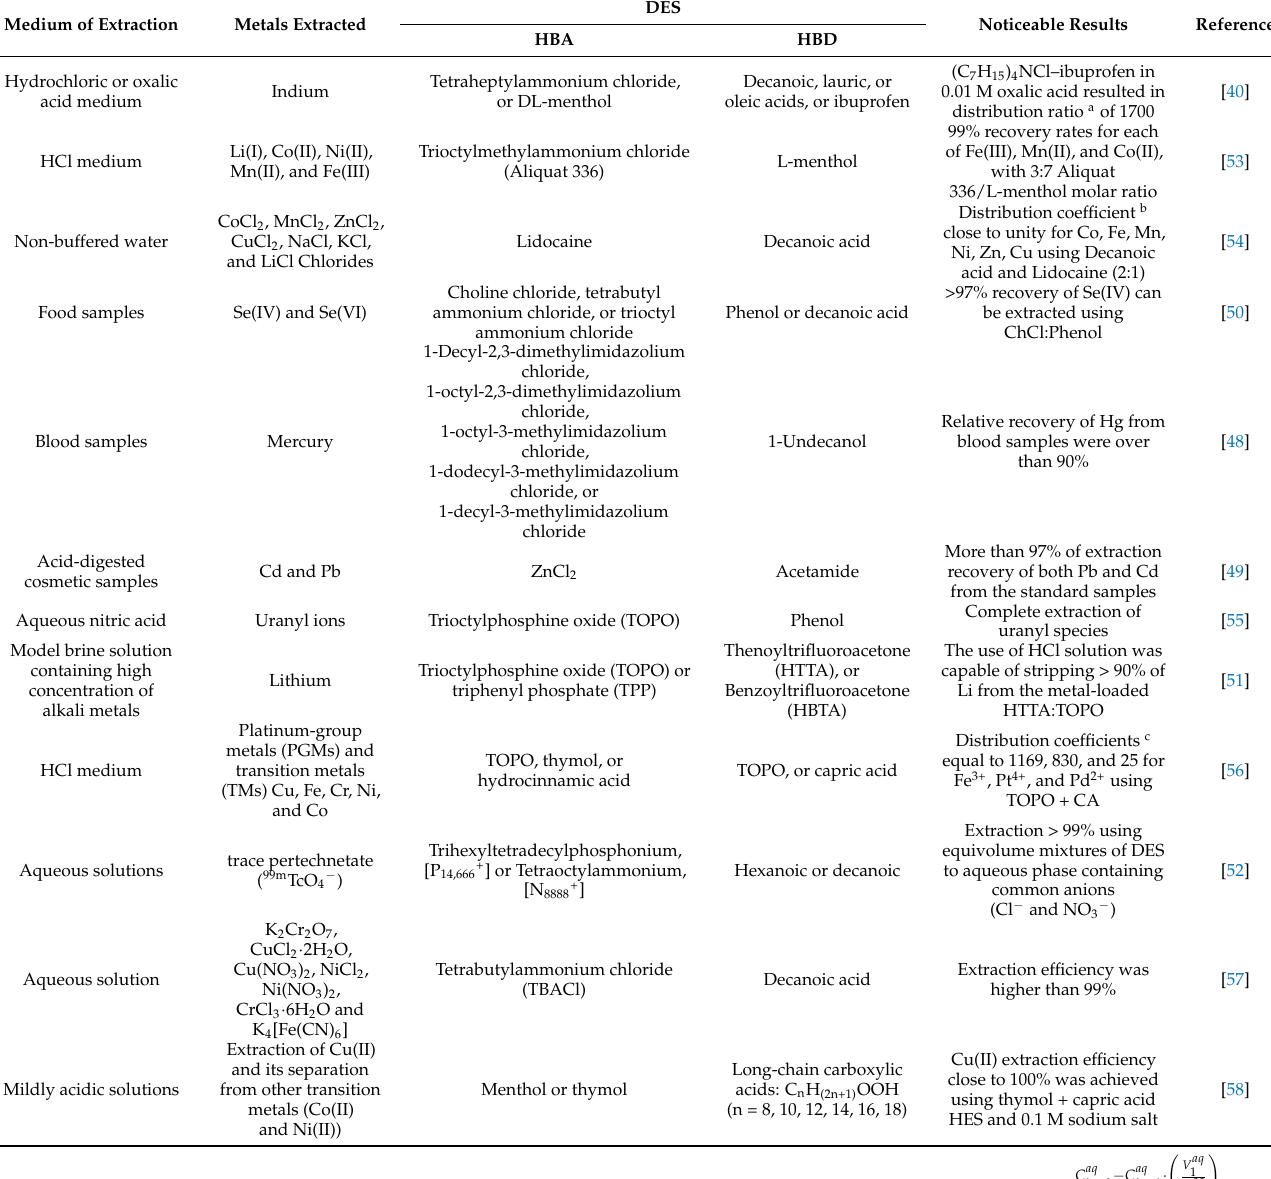
Table 2. DESs used for the liquid–liquid extraction of metals from